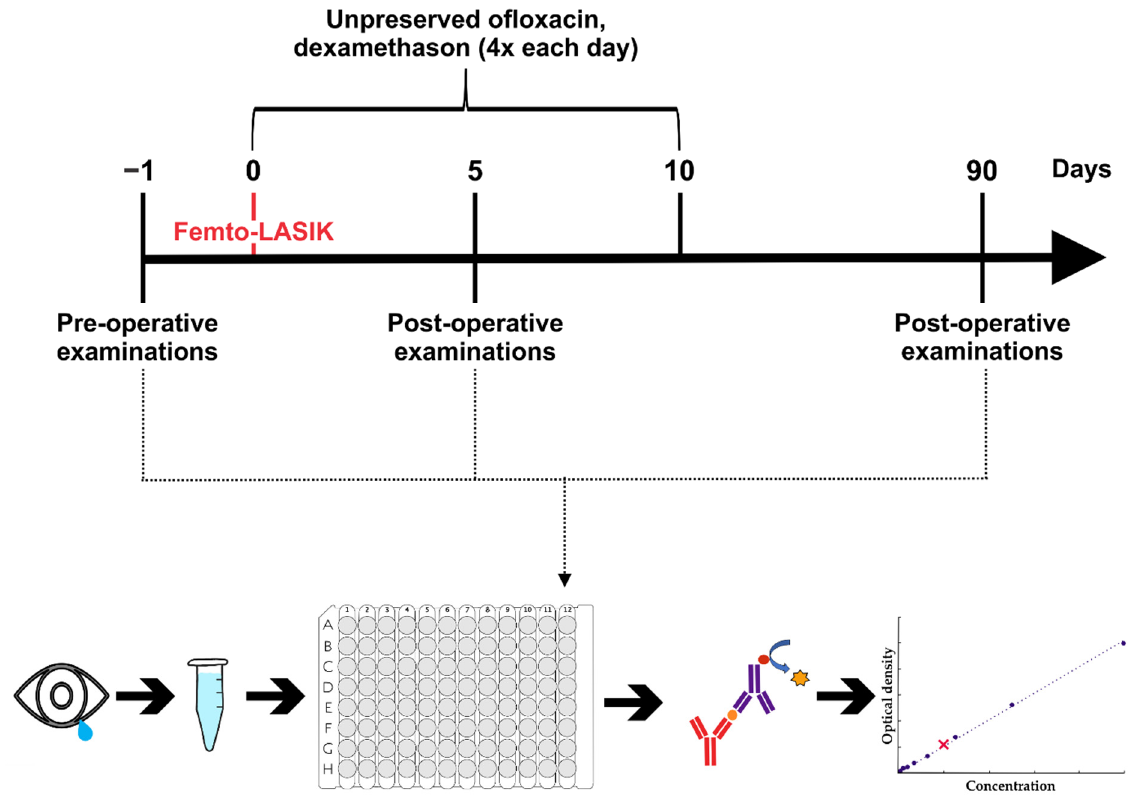
Figure 3. Experimental setup for evaluation of dry eye symptoms and protein alterations after Femto-LASIK. Patients were examined both preoperatively as well as 5 and 90 days after LASIK. Both, classic dry eye examinations and analyzes of the protein concentration in the tear film were carried out. Tear film was obtained using Schirmer strips, eluted and transferred to an ELISA plate. The quantity of altered proteins was determined using specific antibodies in commercially available ELISA kits.